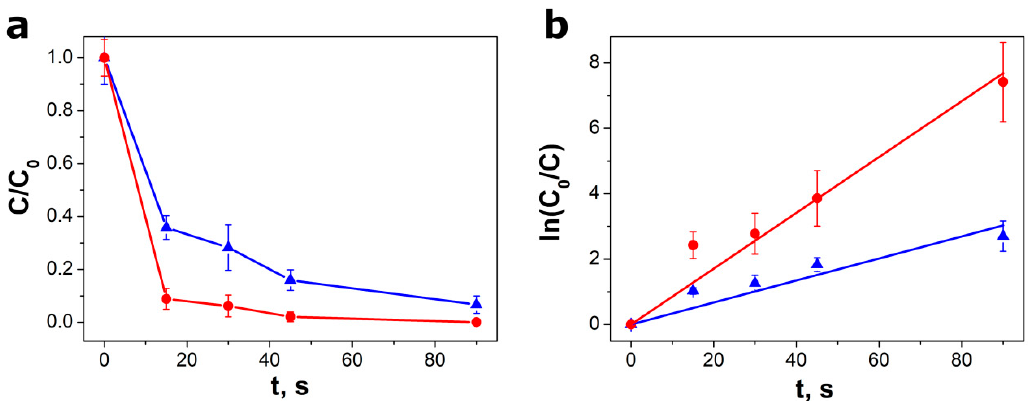
Figure 5. Plots of ( a ) methyl orange relative concentrations C / C 0 and ( b ) ln(C 0 / C) versus vibration time for two different ratios of SbSI piezocatalyst mass to the initial MO mass in aqueous solution ( ● —m p /m MO = 200, ▲ —m p /m MO = 100). Red and blue lines in graph ( b ) represent the best fitted dependence described by Equation (1). Piezocatalysis was performed using Sonic-6 (Polsonic) reactor with ultrasound frequency f = 40 kHz and power P = 480 W.